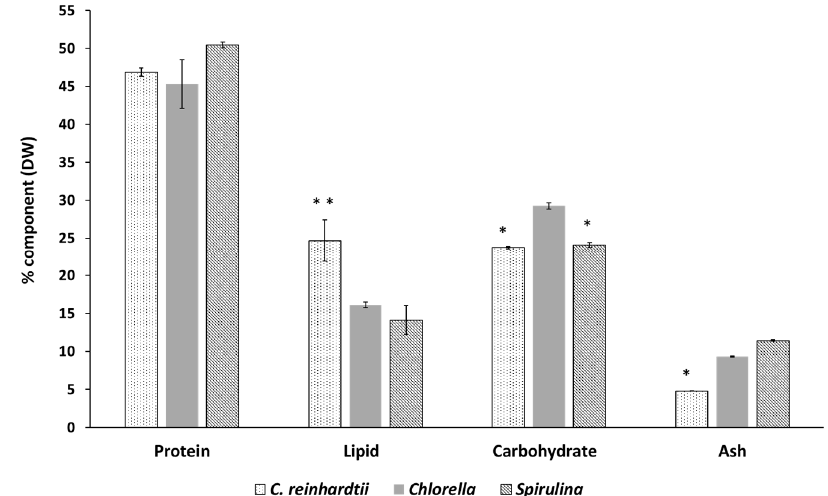
Figure 2. Macronutrient content of Chlamydomonas reinhardtii , Spirulina and Chlorella on dry weight (DW) basis. Results are the means of triplicate determinations ± SD. Values with two asterisks (**) are significantly higher within the same component and those with one asterisk (*) are significantly lower within the same component at ( p ≤ 0.05) using Tukey’s test. Carbohydrate content was calculated by difference: Carbohydrate = 100 − (Protein + Lipid + Ash).